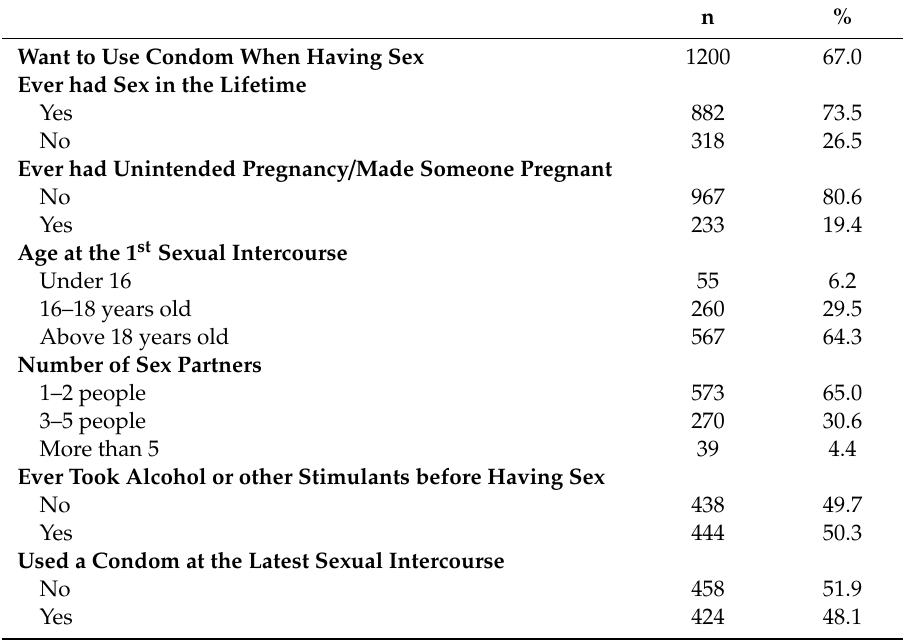
Table 2. Attitude and practice on sexual